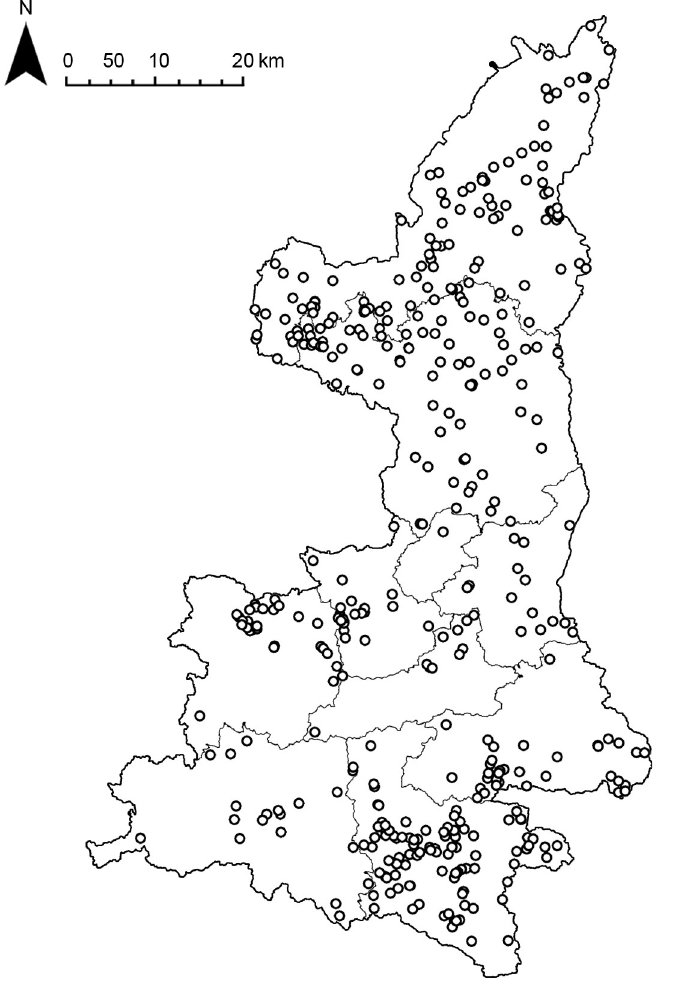
Fig 1. Distribution map of fort-type settlements in